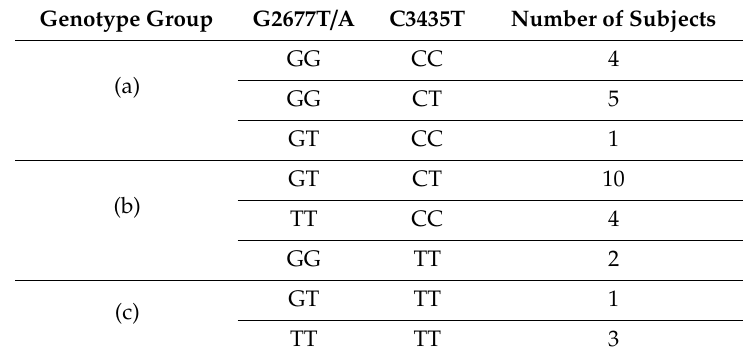
Table 1. Stratification of volunteers in genotypic groups according to MDR1 genotypes regarding